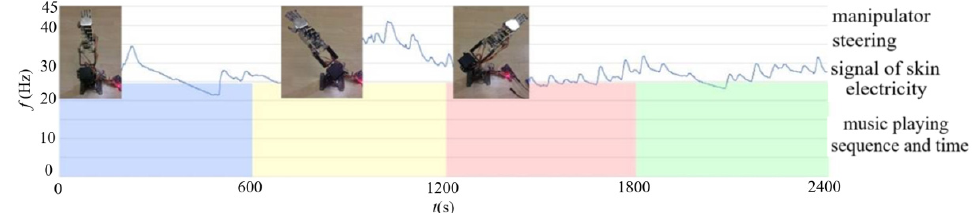
Figure 15. Manipulator steering change driven by